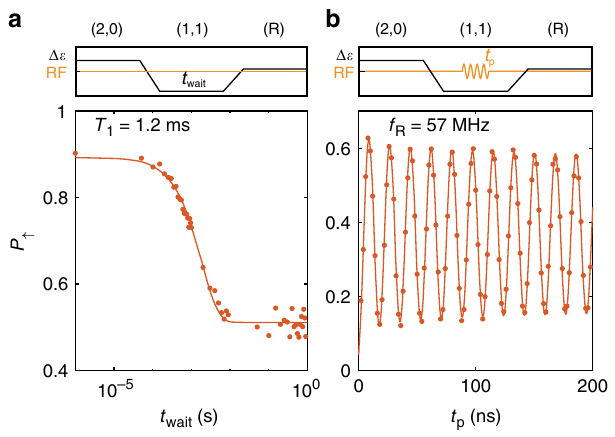
Fig. 3 Spin relaxation and coherent driving of a single hole. a The system is initialised in the #"j i state after which the qubits idle at the measurement point. The spin-up fraction P ↑ of Q2 is measured as a function of waiting time t wait and shows a typical T 1 -decay with a relaxation time of T 1 = 1.2 ms. b Driving of the single-hole qubit Q2 shows coherent oscillations in P ↑ as a function of the microwave pulse length t p . The coherent operation of Q1 is shown in Supplementary Fig. 4.